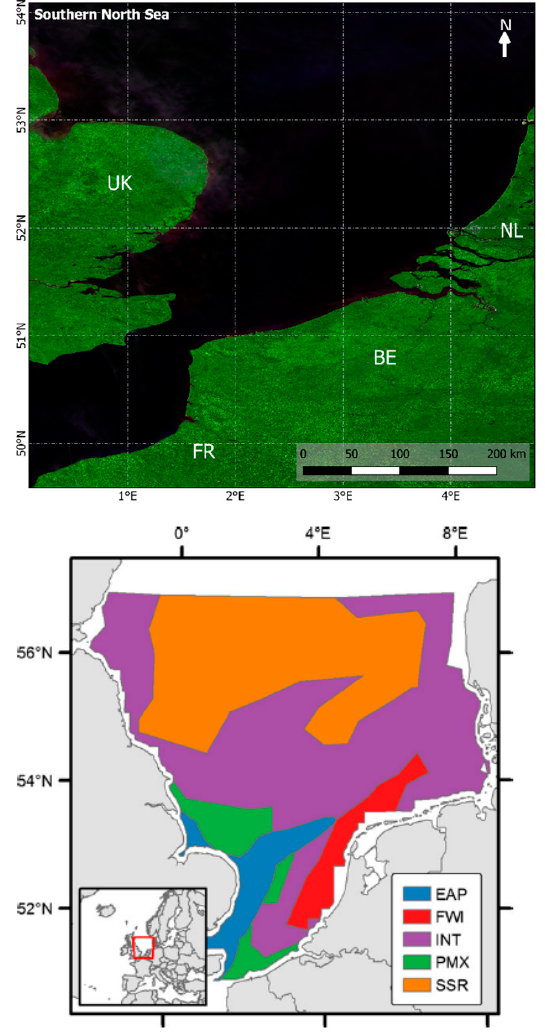
Figure 1. ( top ) Project for On-Board Autonomy-Vegetation (PROBA-V) image of the region of interest and ( bottom ) the study area and the hydrodynamic regions: EAP, East Anglia Plume; FWI, freshwater influence; INT, intermediate; PXL, permanently mixed and SSR, seasonally stratified [18].